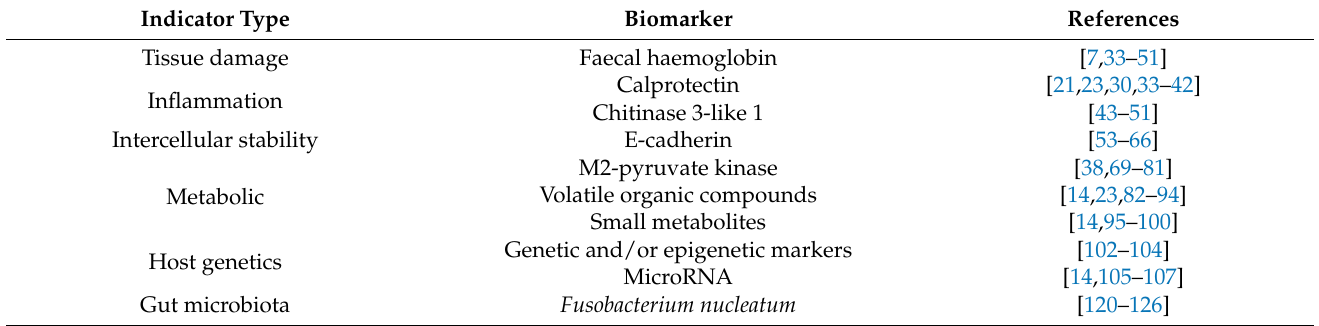
Table 1. Noninvasive